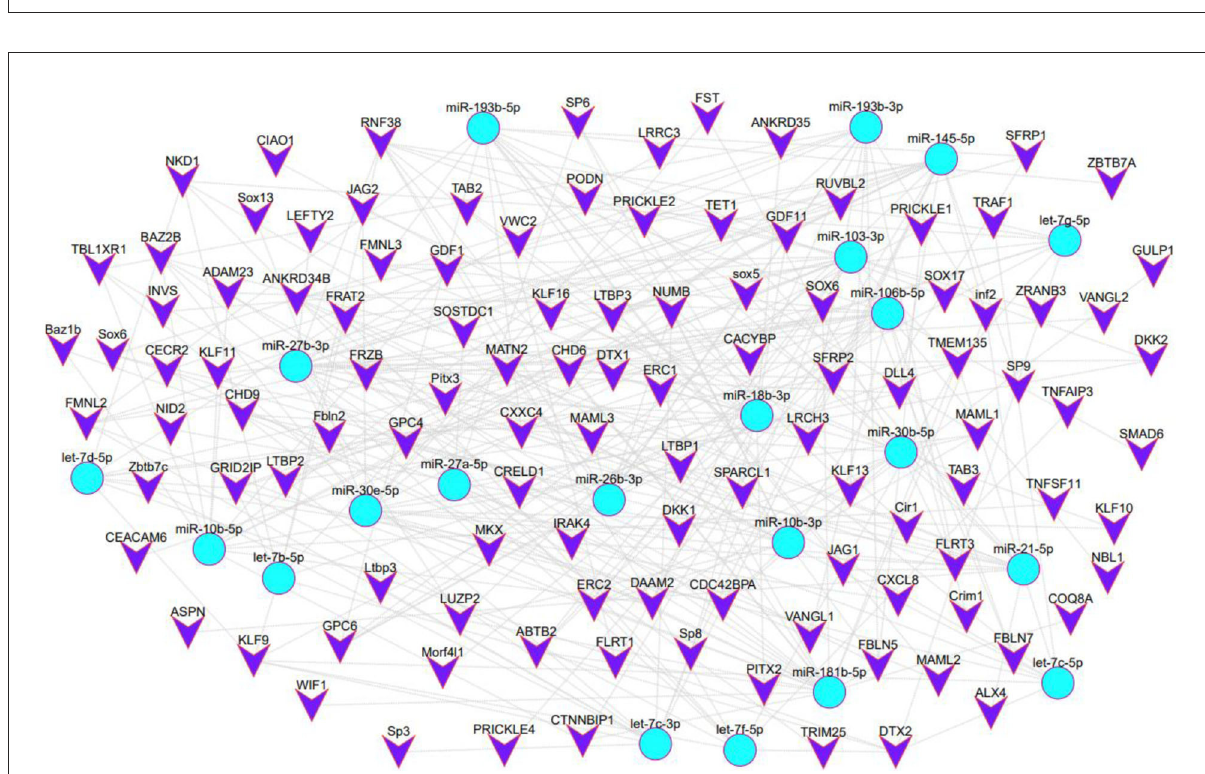
FIGURE5 The regulatory network of miRNA-mRNA related to secondary hair follicle development.